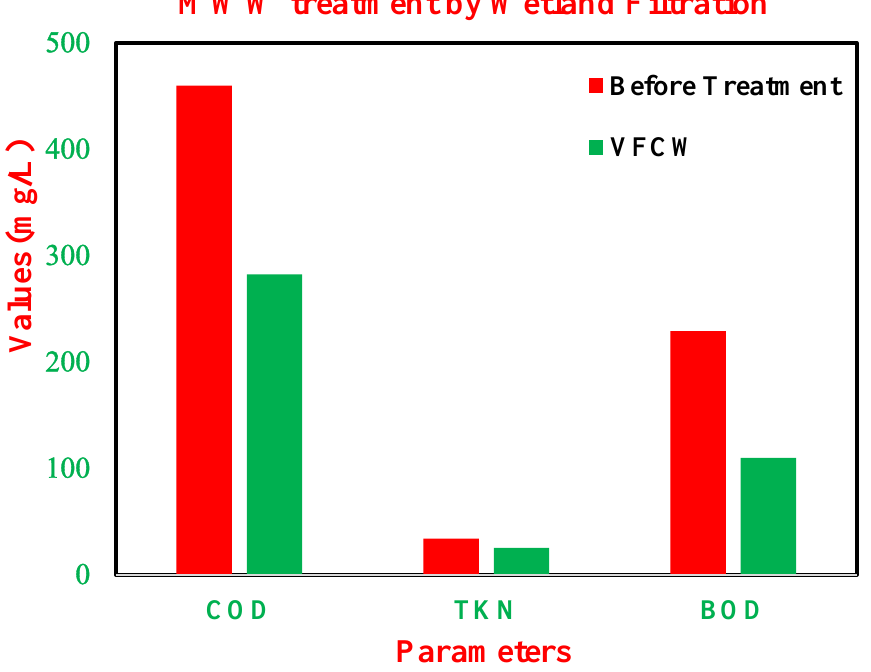
Figure 5. Municipal wastewater treatment using VFCW indicates the COD, TKN and BOD values.